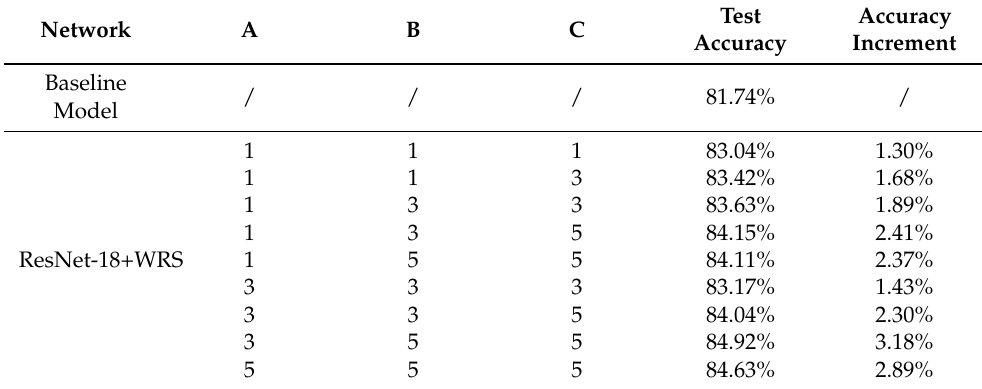
Table 6. Effect of the size of the convolution kernel on the WRS branch.